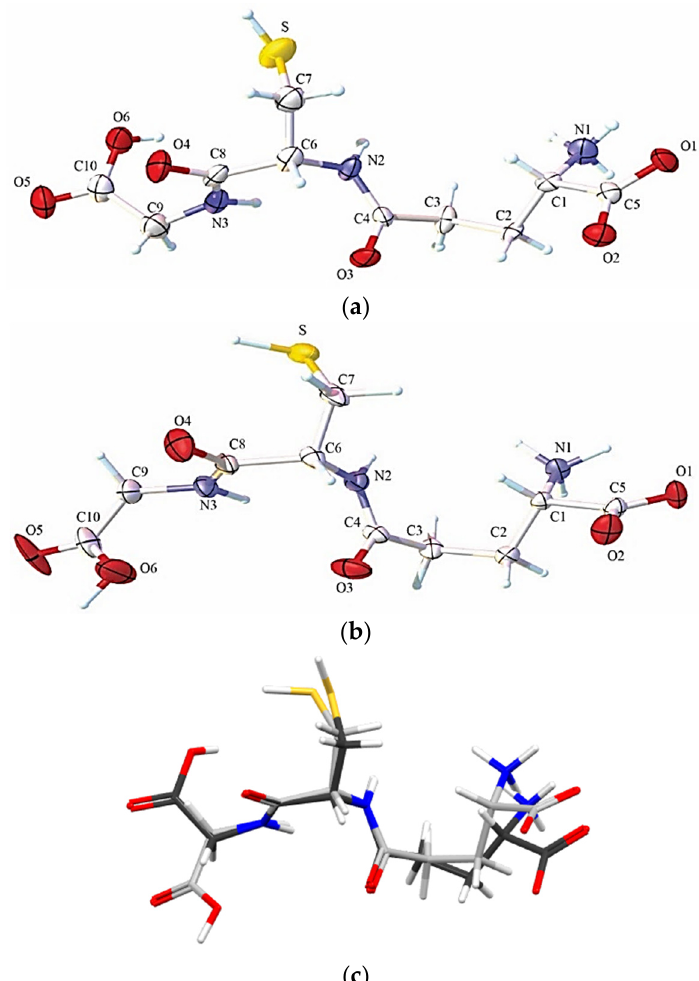
Figure 1. ORTEP diagram for ( a ) GSHA, ( b ) GSHB, and ( c ) the overlapping structure. The ellipsoids are represented at a 75% probability level with the atomic numbering scheme. The hydrogen atoms are represented by spheres with arbitrary radii. ( c ) The overlap of GSHA and GSHB polymorphs.